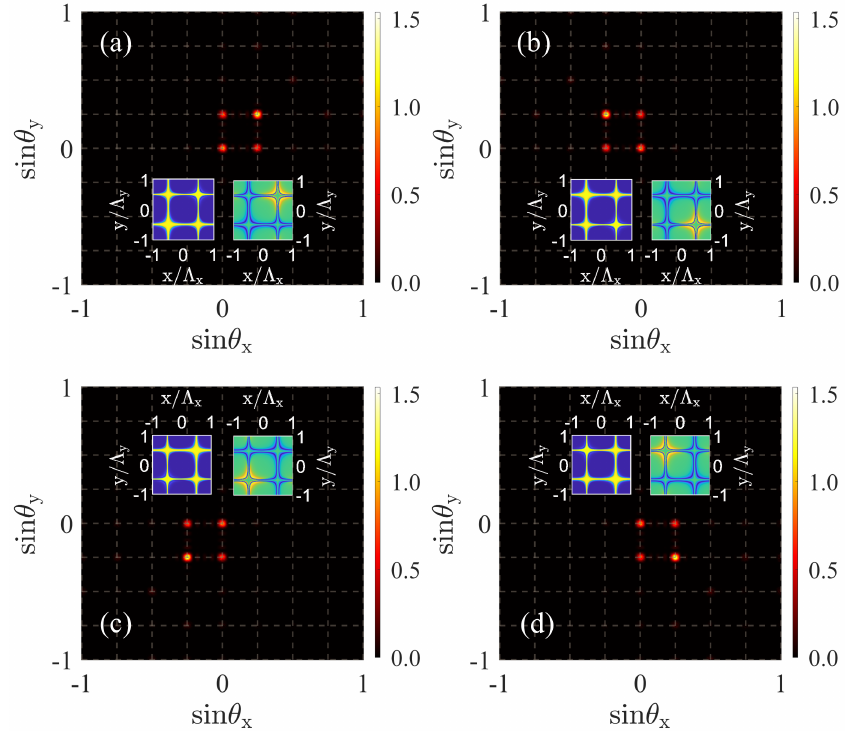
Figure 5. Same as Figure 2f except α x = π /2 and α y = π /2, as well as ( a ) β x = 0 and β y = 0; ( b ) β x = 0 and β y = π ; ( c ) β x = π and β y = π ; ( d ) β x = π and β y = 0. The insets show corresponding absorption (left) and dispersion (right) distributions plotted as χ I p ( x , y ) and χ R p ( x , y ) ,